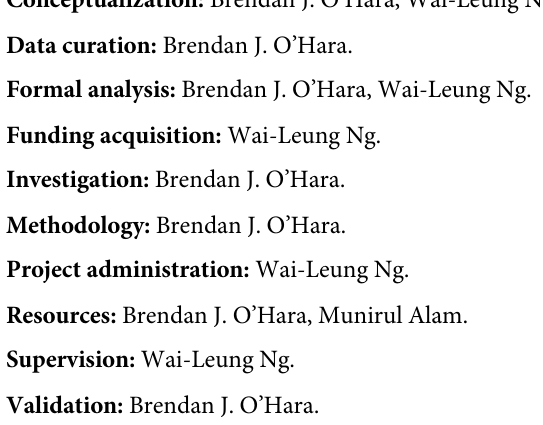
shown separately for clarity. WT data is therefore identical for these two graphs. S3 Fig. Effect of avcD and ddmC expression on bacterial growth. Growth curves of V . cho- lerae (A) and E . coli (B) carrying the plasmid pMMB67eh with the indicated insert +/- 100 μ M IPTG. Average of at least three biological replicates are shown. (C) V . cholerae Δ avcD Δ ddmC strain containing the plasmid pMMB67eh or the same plasmid expressing avcD or ddmC was grown and infected with M1 F at an MOI of 2. All strains induced with 100 μ M IPTG (D) Δ VSP-I Δ VSP-II V . cholerae containing the plasmid pMMB67eh with the indicated insert were grown in inducing conditions with 100 μ M IPTG. S4 Fig. Polymorphism in the ICP3 DNA Polymerase (GP22). Scale diagram of the ICP3 polymerase GP22 with the black boxes indicating the well conserved exonuclease and DNA Polymerase A domains. Breakout alignment of M1 and M2 gp22 was performed with T-Coffee and display was generated using GENEDOC. Single amino acid change can be seen as black text on a grey background. S1 Table. Summary of phage found in stool samples. S2 Table. Bacterial strains used in this study. S3 Table. Oligonucleotides used in this